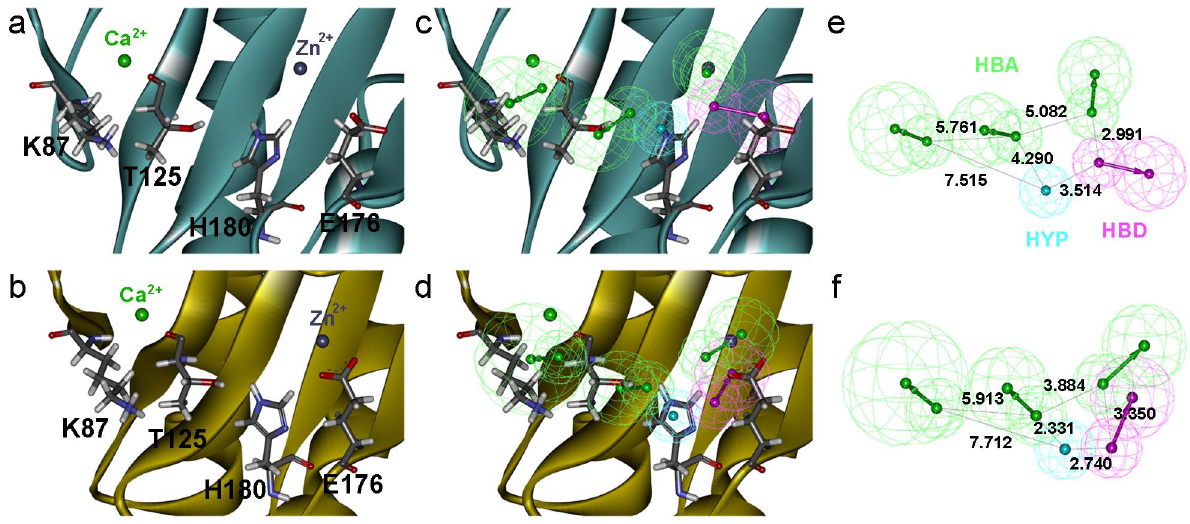
Figure 4. Design of structure-based pharmacophore models. The metal ions and key residues of the representative Shh structure of (a) the Shh-PL2 (slashdot green) and (b) the Shh-robotnikinin (gold). The zinc and calcium ions are marked by blue-gray and green spheres, and the key residues are represented by stick model. Chemical features are color coded as follows: HBA, green; HBD, magenta; HYP, cyan. Selected chemical features based on the representative Shh structure generated from (c) the Shh-PL2 and (d) Shh-robotnikinin. Completed pharmacophore models of (e) the Shh-PL2 and (f) Shh-robotnikinin.